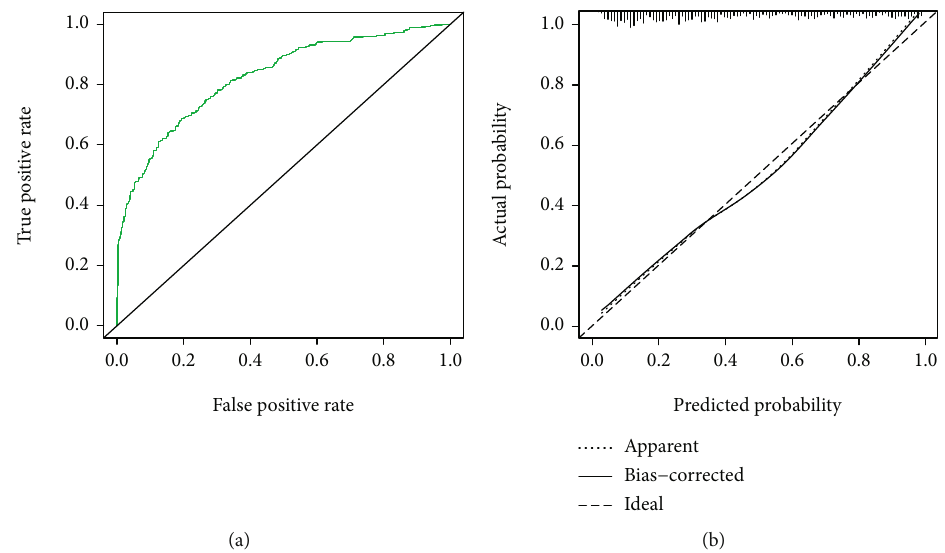
Figure 2: (a) ROC curve of the nomogram for predicting MACEs after PCI in AMI patients. (b) Calibration curve of the nomogram for the prediction model. The x -axis represents the overall predicted probability of revascularization after PCI, and the y -axis represents the actual probability. Model calibration is indicated by the degree of fi tting of the curve and the diagonal. Abbreviations: AUC: area under the ROC curve; ROC: receiver operating characteristic; MACEs: major adverse cardiovascular events; PCI: percutaneous transluminal coronary intervention; AMI: acute myocardial infarction.